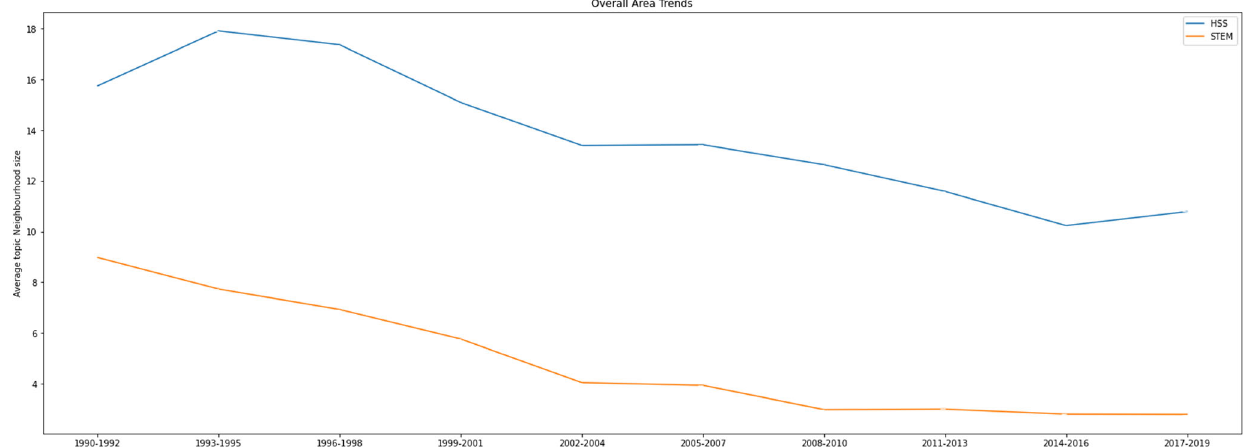
Fig. 2 Average neighbourhood size of FoR embeddings over time. HSS discipline embeddings are in blue and STEM discipline embeddings are in orange.